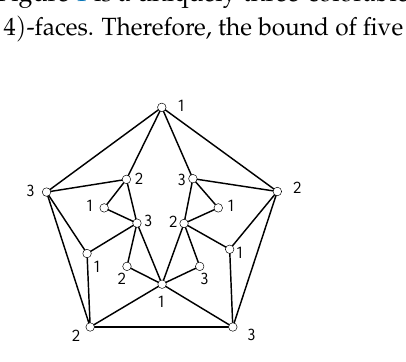
Figure 1. A uniquely three-colorable plane graph having neither adjacent ( 3,3 ) -faces nor adjacent ( 3,4 )